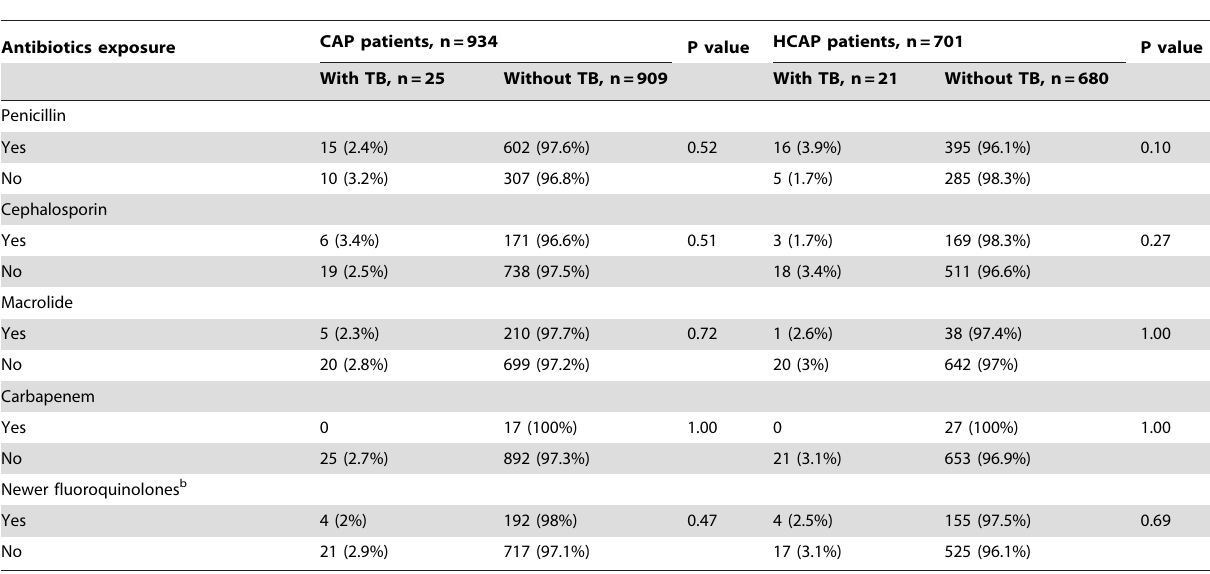
Table 3. Relationships between antibiotics exposure and the occurrence of concomitant pulmonary tuberculosis in HCAP and CAP patients a .